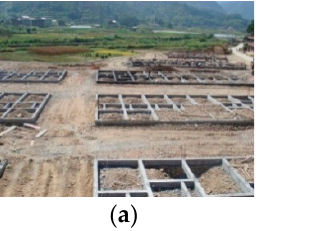
Table 2. Registration table of a water area (source: http://www.wl.gov.cn/art/2018/10/19/art_1402221_22027457.html, 26 October 2021). Applicant Location Geographical Coordinates (CSCS2000) Acreage (Hectare) Breeding Methods